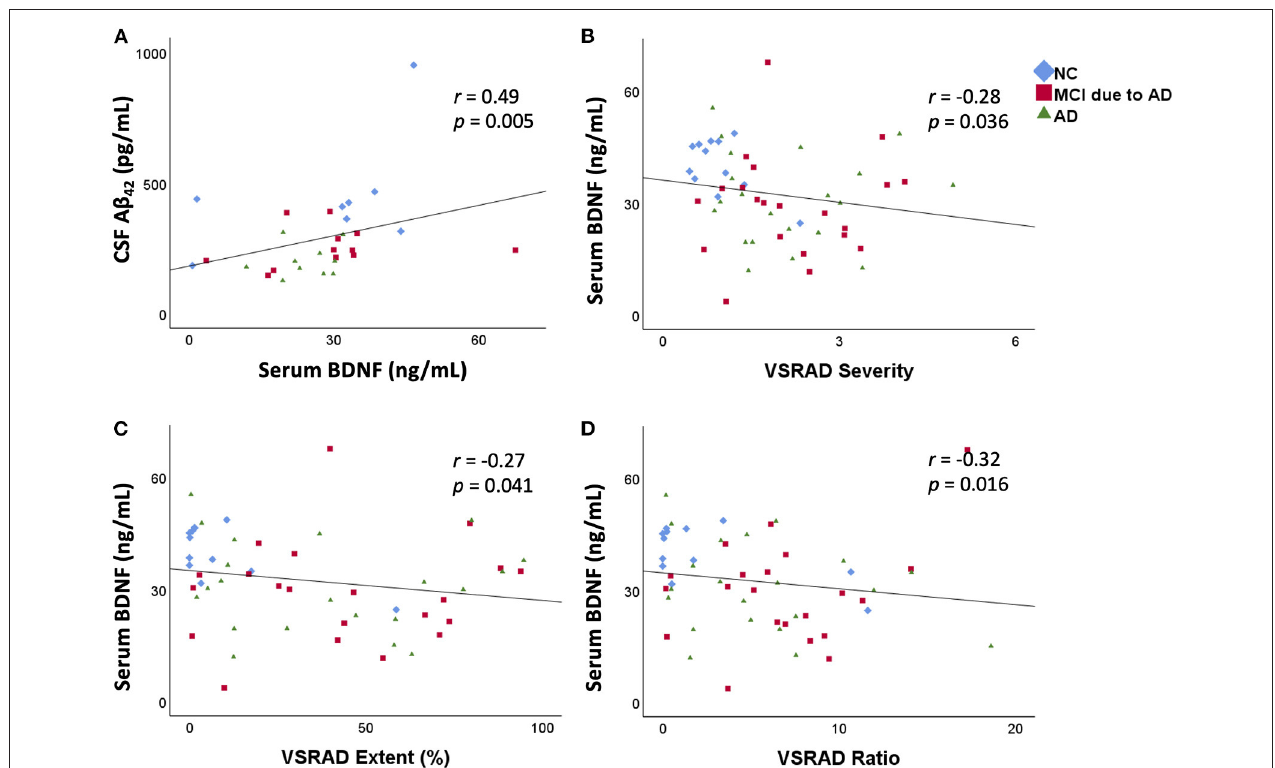
FIGURE 2 | Correlation between serum BDNF levels and CSF A β 42 levels and the relation between serum BDNF levels and medial temporal lobe atrophy. Serum BDNF levels were positively correlated with CSF A β 42 levels ( r = 0.49, p = 0.005) ( A ). Serum BDNF levels were significantly negatively correlated with VSRAD Severity ( B ), VSRAD Extent ( C ), and VSRAD Ratio ( D ). VSRAD software, for the analysis of MR images, is widely used in the clinical diagnosis of AD in Japan for assessment of medial temporal lobe atrophy. In the present study, we used four VSRAD scores for imaging analysis (22). VSRAD Severity indicates the degree of atrophy of the medial temporal lobe region associated with memory. VSRAD Extent is the ratio of the atrophic area in the medial temporal lobe region. VSRAD Ratio shows the strength of selective atrophy. BDNF, brain-derived neurotrophic factor; CSF, cerebrospinal fluid; A β , amyloid- β protein; AD, Alzheimer’s disease; NC, normal control; MCI, mild cognitive impairment; VSRAD, voxel-based specific regional analysis system for